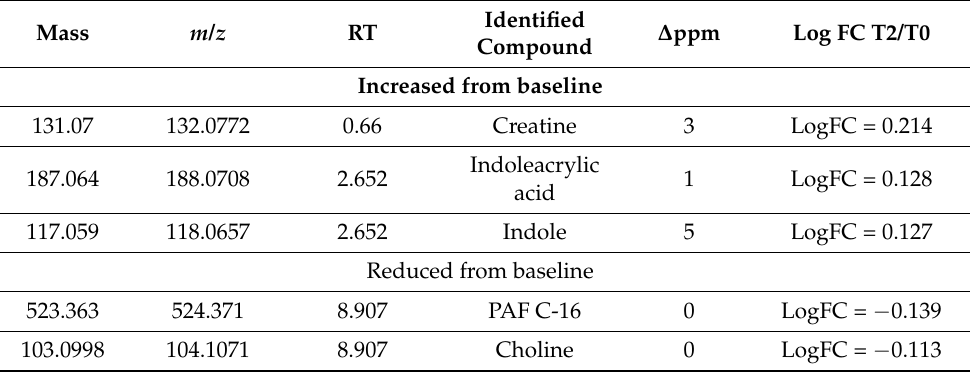
Figure 2. Volcano plots and scatter plot. The statistical analysis results for compounds analyzed in negative ion mode are summarized as a volcano plot of log2 fold-change (x-axis) versus − log10 p -values (y-axis), for three experimental designs: T1 vs. T0 ( panel A ), T2 vs. T0 ( panel B ), and T2 vs. T1 ( panel C ). Colored dots are the differentially abundant compounds: light blue and dark blue dots are compounds downregulated at p -value < 0.05 and adjusted p -value < 0.05, respectively; orange and red dots are compounds upregulated at p -value < 0.05 and adjusted p -value < 0.05, respectively. Scatter plot ( panel D ) shows the trend over time of 19 differentially expressed compounds (adjusted p -value < 0.05). These data refer to the 5 compounds maximally modified after 12 weeks of treatment with Evolocumab ® , having a Benjamini–Hochberg false discovery rate-corrected p -value < 0.05. Table 3. Identification of compounds that significantly increase ( n = 3) and decrease ( n = 2) after 12 weeks of treatment with PCSK9